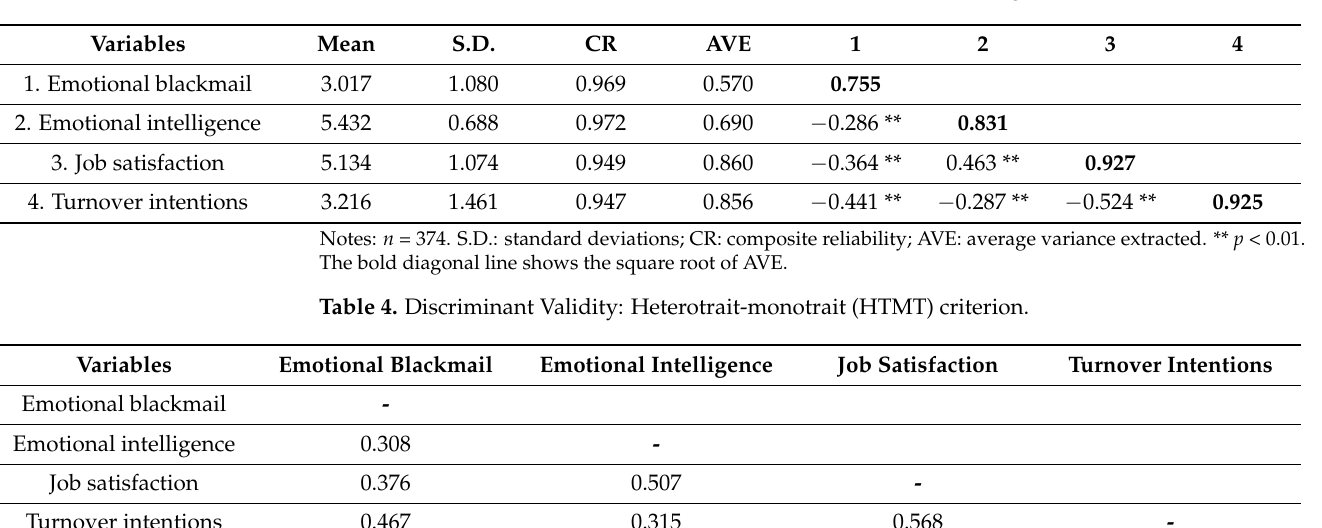
Table 3. Means, standard deviations, CR, AVE, and correlations among variables.